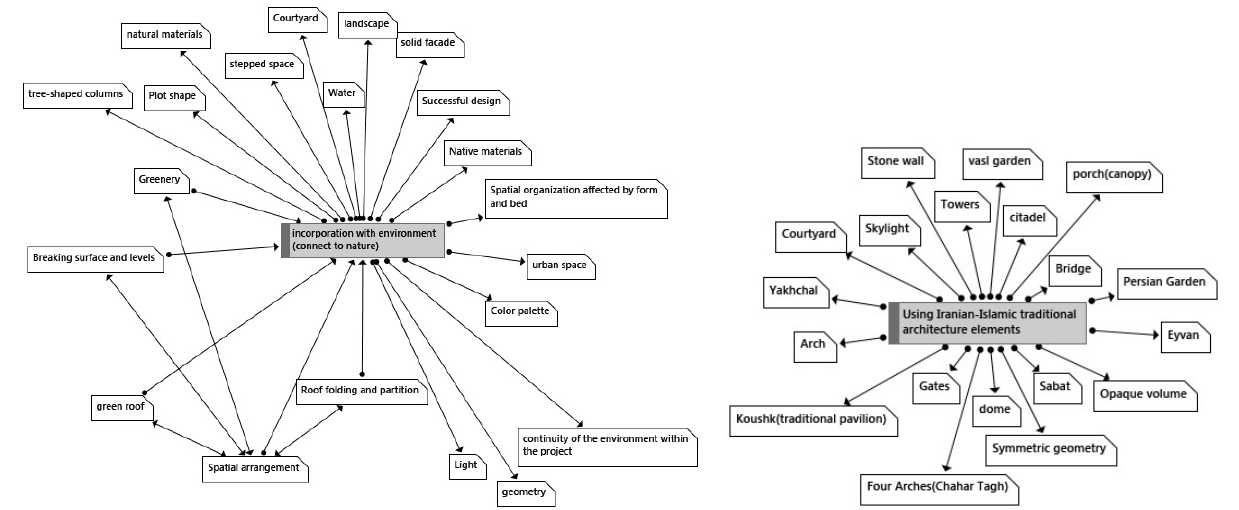
Figure 14. Codes related to “incorporation with environment” Figure 15. Codes related to Iranian architectural